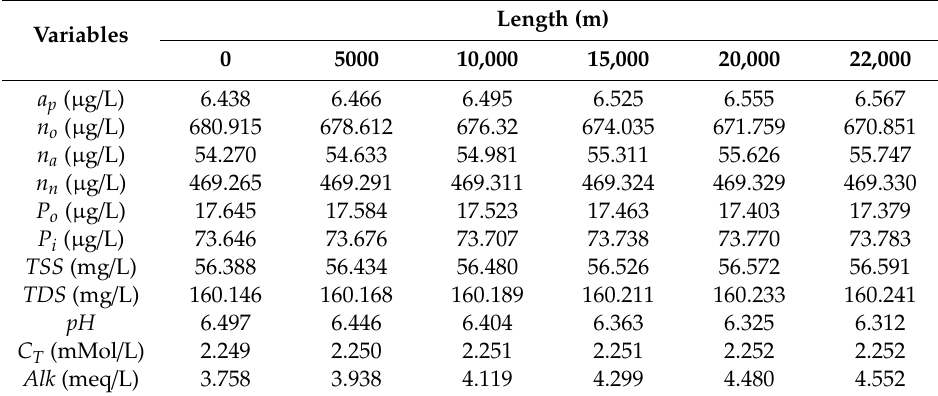
Table 14. Sub-canal water quality simulation